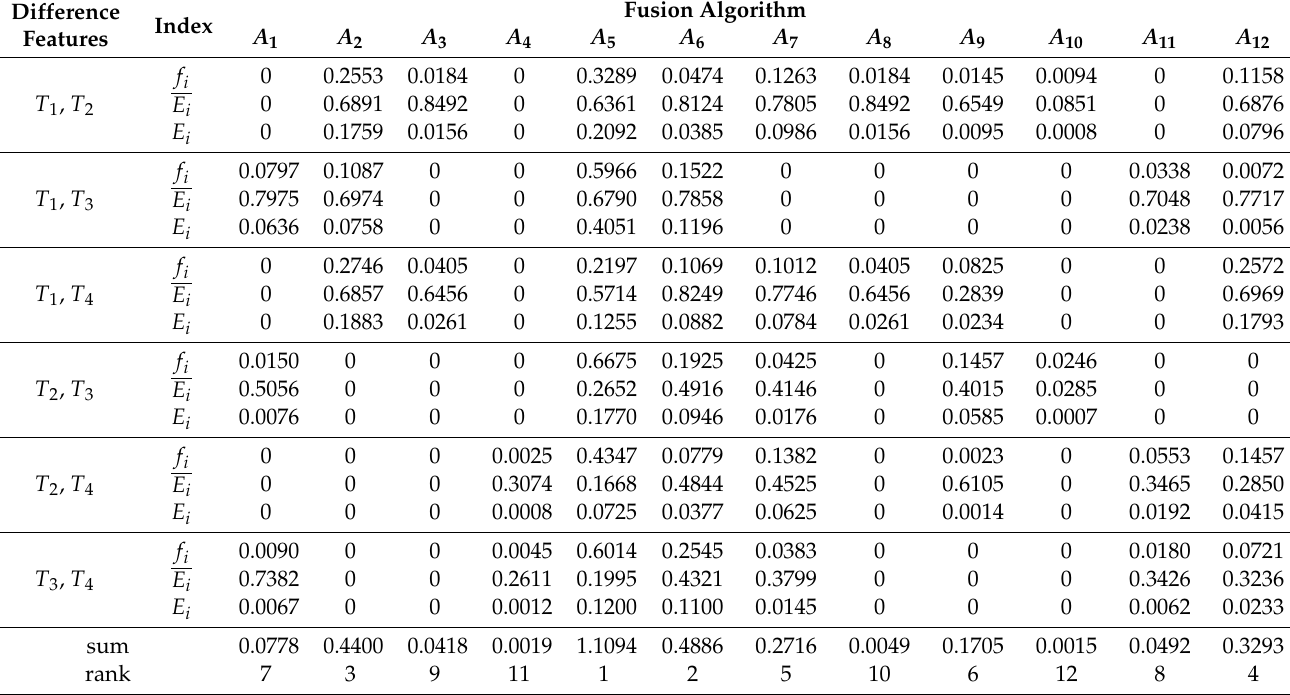
Table 6. E i of each fusion algorithms of the second